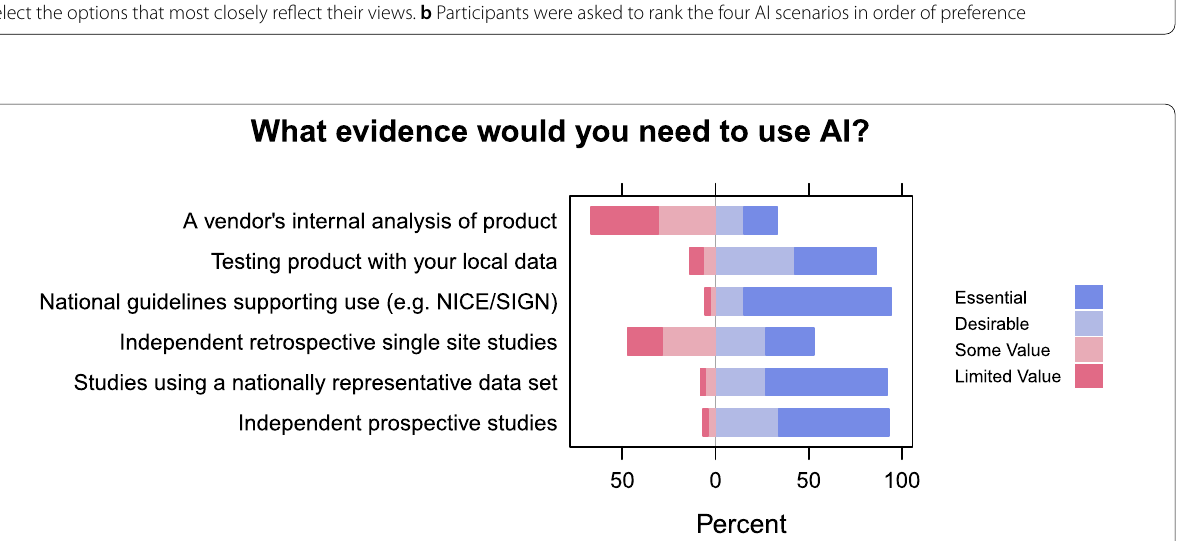
Fig. 2 What evidence do you need to introduce AI into your workplace? Participants were asked: ‘What type of evidence would convince you of the value and utility of AI in breast screening and support AI introduction into your workplace